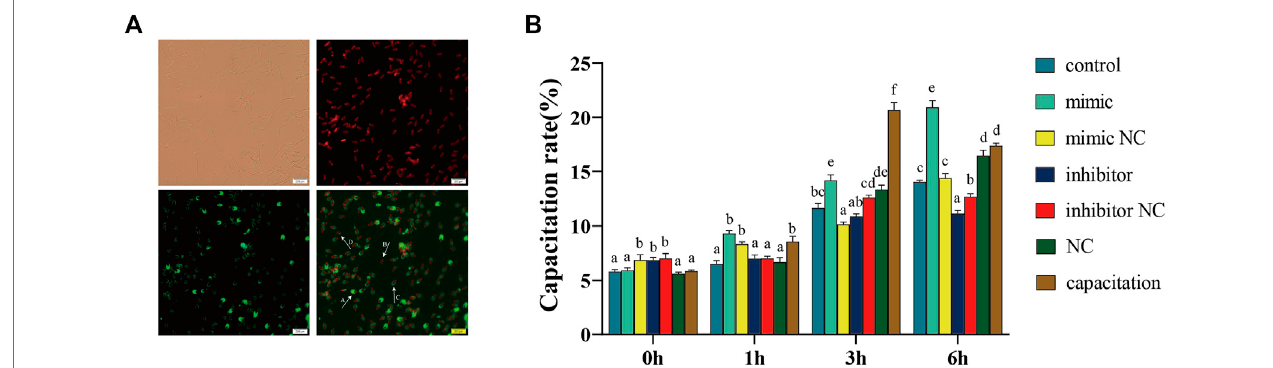
FIGURE 4 | (A) Assessment of the acrosomal status and capacitation rate at 37 ° C by a PNA/PI staining assay. Furthermore, 40 ng/ml heparin was used to stimulate acrosome reaction as the positive control. A: integral acrosome (green, PI − /PNA + ), B: dead sperm (red, PI + /PNA − ), C: acrosomal reaction (green/red, PI + / PNA + ),D:damagedacrosomeandincompletemembrane(green/red,PI + /PNA + ). (B) ThecapacitationrateisequaltothesumofCgroupdividedbythetotalsperm.The data are representative of at least three independent experiments (mean ± SEM).